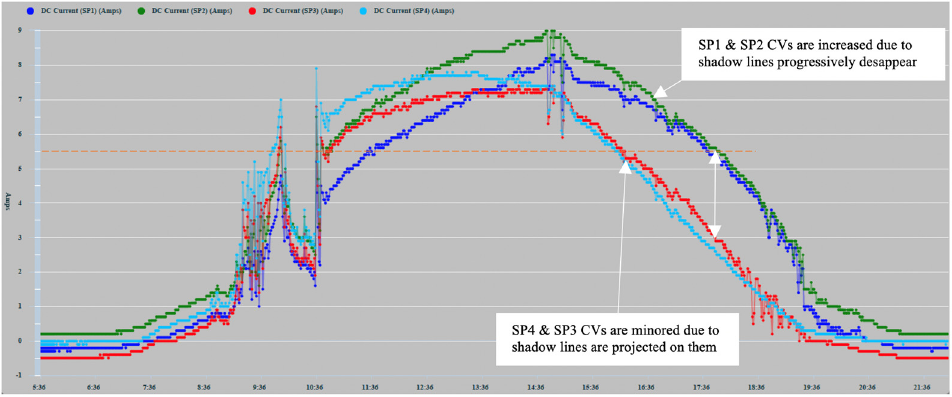
Figure 16. Time series of the generation of current values (CV) of 18 May 2021.